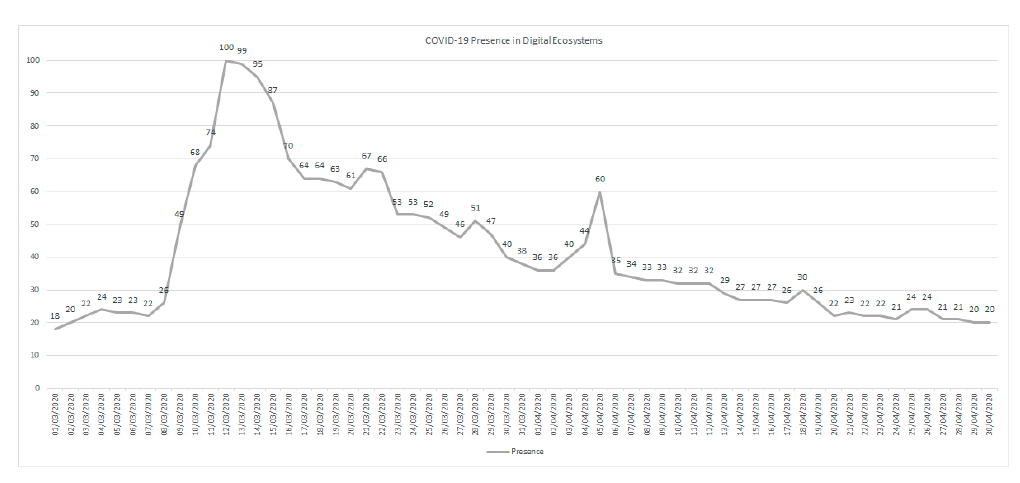
Figure 14. Presence Analysis in Digital Ecosystems during the period 1 March 2020 until 30 April 2020 related to terms about